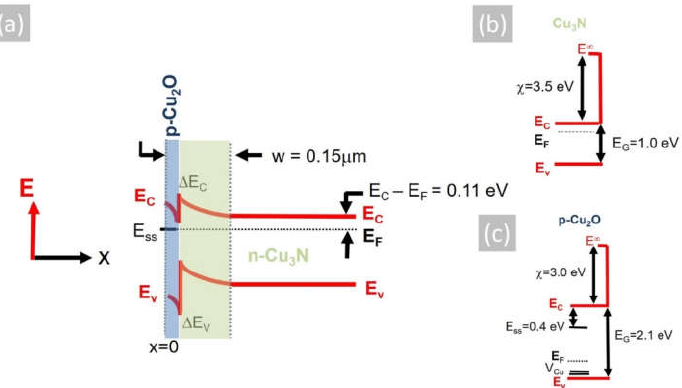
Figure 5. ( a ) Energy band potential profile of a Cu 2 O/Cu 3 N p-n heterojunction consisting of n-type Cu 3 N and the native, surface p-type Cu 2 O, where the Fermi level (E F ) is pinned at the surface states (E ss ) residing ~0.4 eV below the conduction band edge of Cu 2 O; also shown are the conduction ( E C ) and valence ( E V ) band discontinuities as well as the surface depletion w that extends 0.15 µm through the p-type Cu 2 O and into the n-type Cu 3 N. ( b ) Energy band diagram of n-type Cu 3 N showing the conduction (E C ) and valence (E V ) bands as well as the Fermi level (E F ) and electron affinity (χ) of Cu 3 N, ( c ) same for Cu 2 O; also shown are the (V Cu ) acceptor states, which reside above the top of the valence band, and the energetic position of the surface states (E ss ).